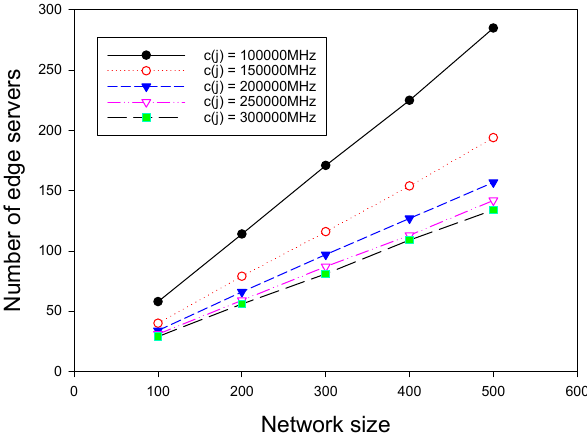
Figure 10. The impact of capacity on the number of edge servers.